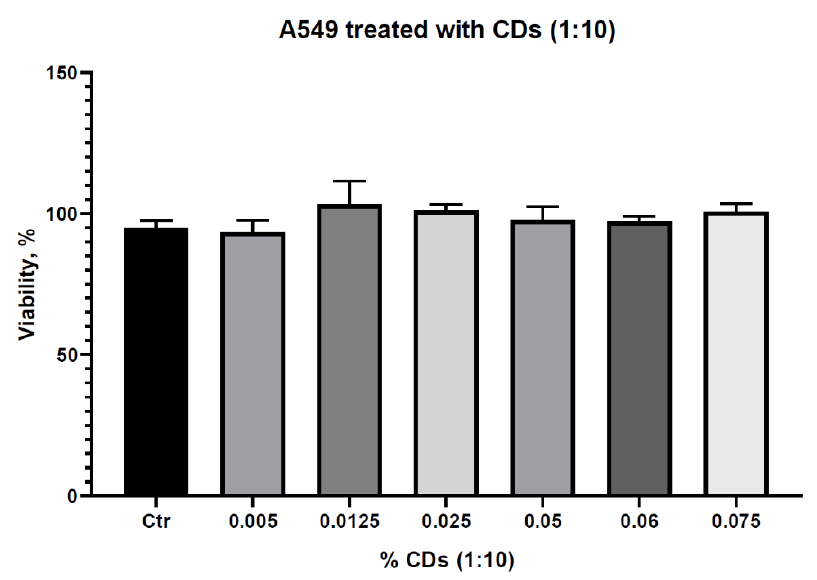
Figure 13. Viability rate of A549 cells toward various concentrations of the as-prepared CQDs solution. Based on the 24 h MTT assay, the viability rate was comparatively plotted between cells treated with different concentrations of CQDs solutions and untreated cells (control group). No statistically significant cytotoxicity of the nanoparticles was highlighted.